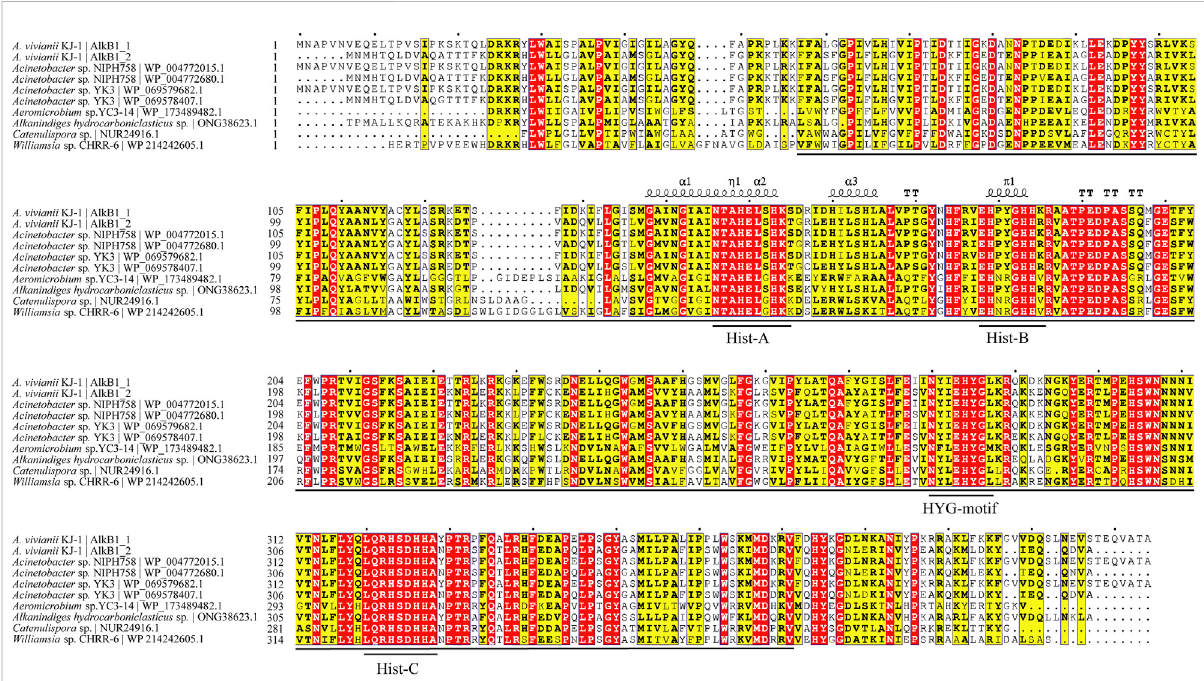
FIGURE 7 Sequence alignment of homologous proteins of AlkB. Fully conserved amino acids are highlighted in red, and semi-conserved amino acids are highlighted in yellow. Conserved domains are marked with horizontal lines. The η symbol refers to a 310-helix. α -helices, 310-helices and π -helices are displayed as medium, small and large squiggles, respectively. β -strands are rendered as arrows, strict β -turns as TT letters and strict α -turns as TTT. The amino acid sequences were aligned by the ClustalW online alignment tool (https://www.genome.jp/tools-bin/clustalw) and then plotted using ESPript3.0 online tool